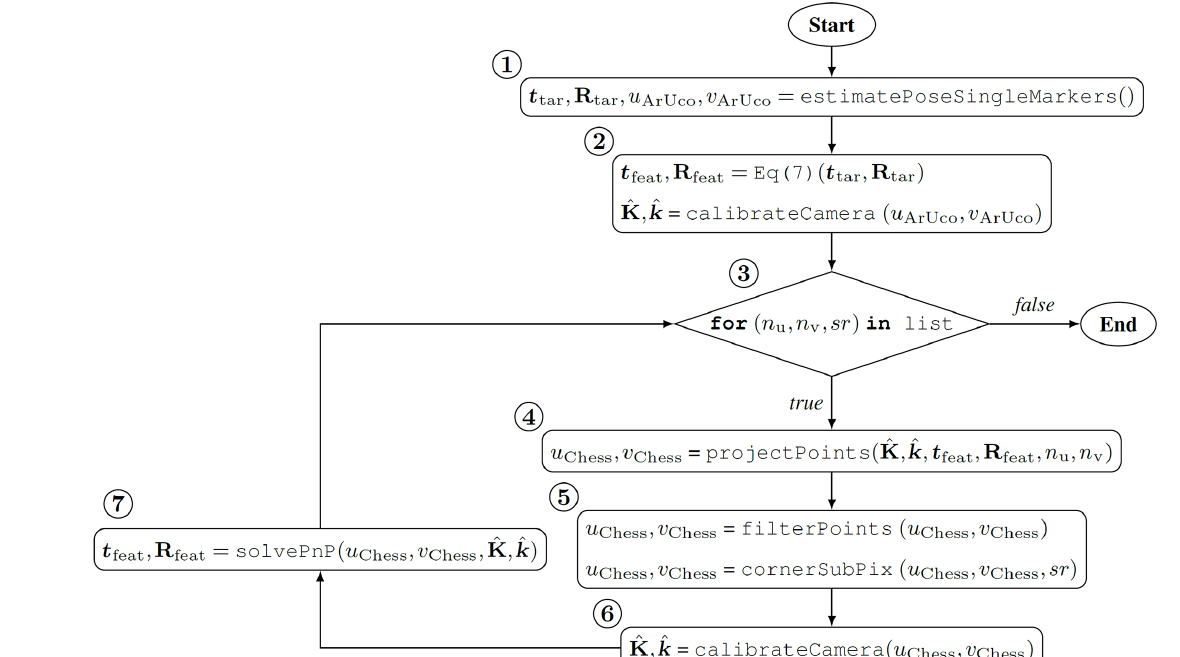
Figure 3. Schematic process flow of the feature detection algorithm.